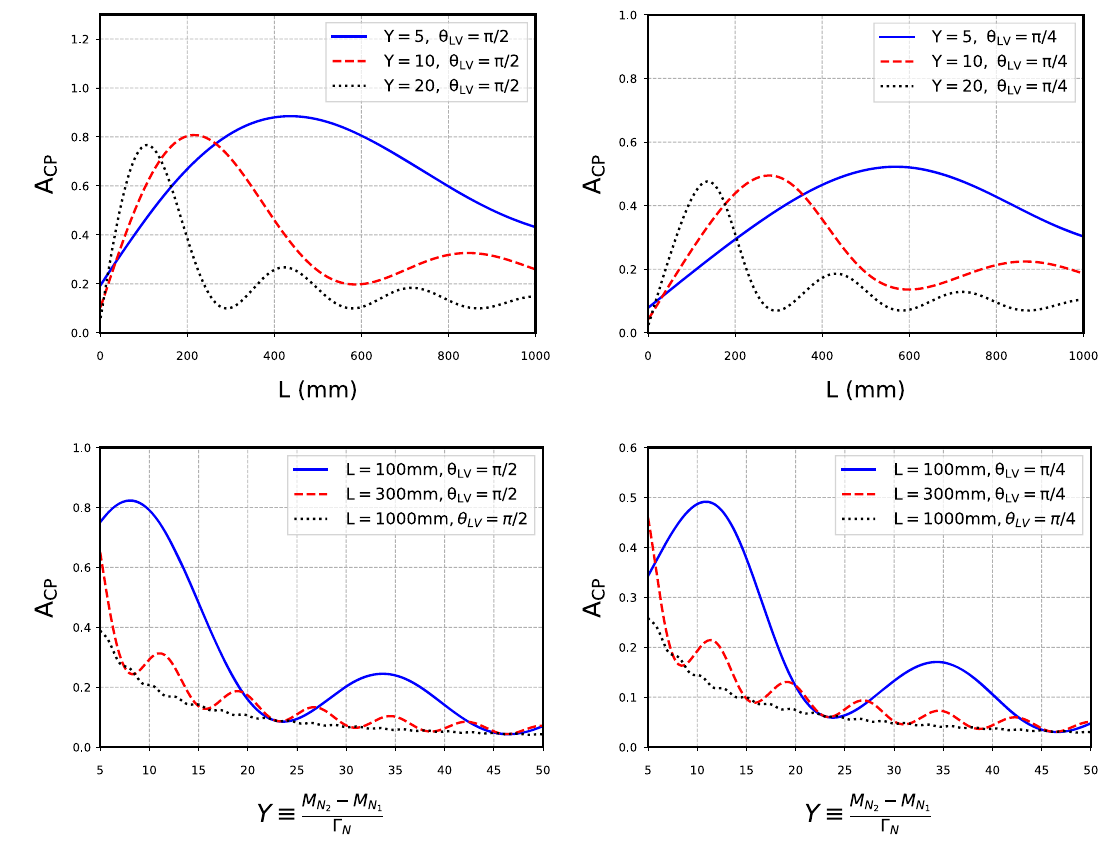
β (cid:11)(cid:11) ( = 664613 ) (Eq. 16) for M N N